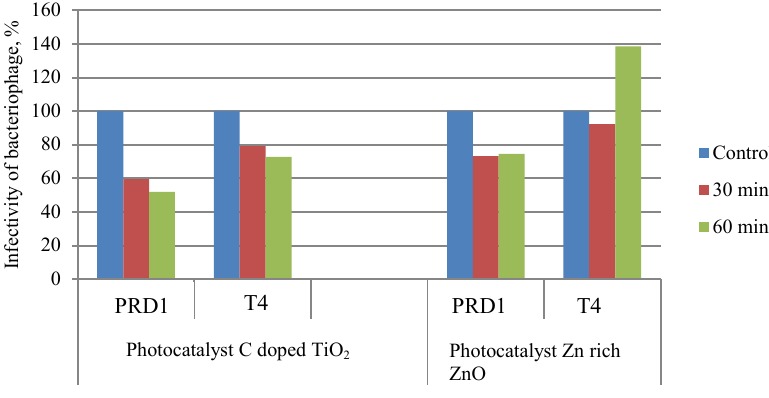
Fig. 7. Infectivity of bacteriophages T4 and PRD1 after photocatalytic treatment of their mixtures. Treatment was performed using visible light and corresponding photocatalyst thin